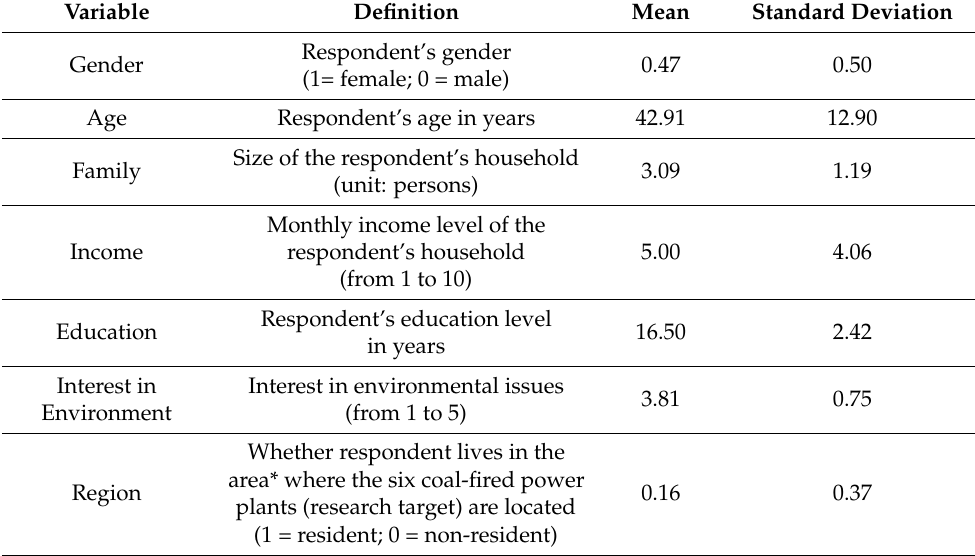
Table 3. Definitions and sample statistics of